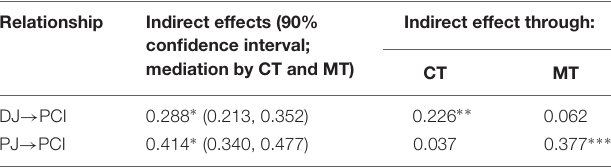
TABLE 2 | Indirect effects through competence-based trust and motive-based trust.